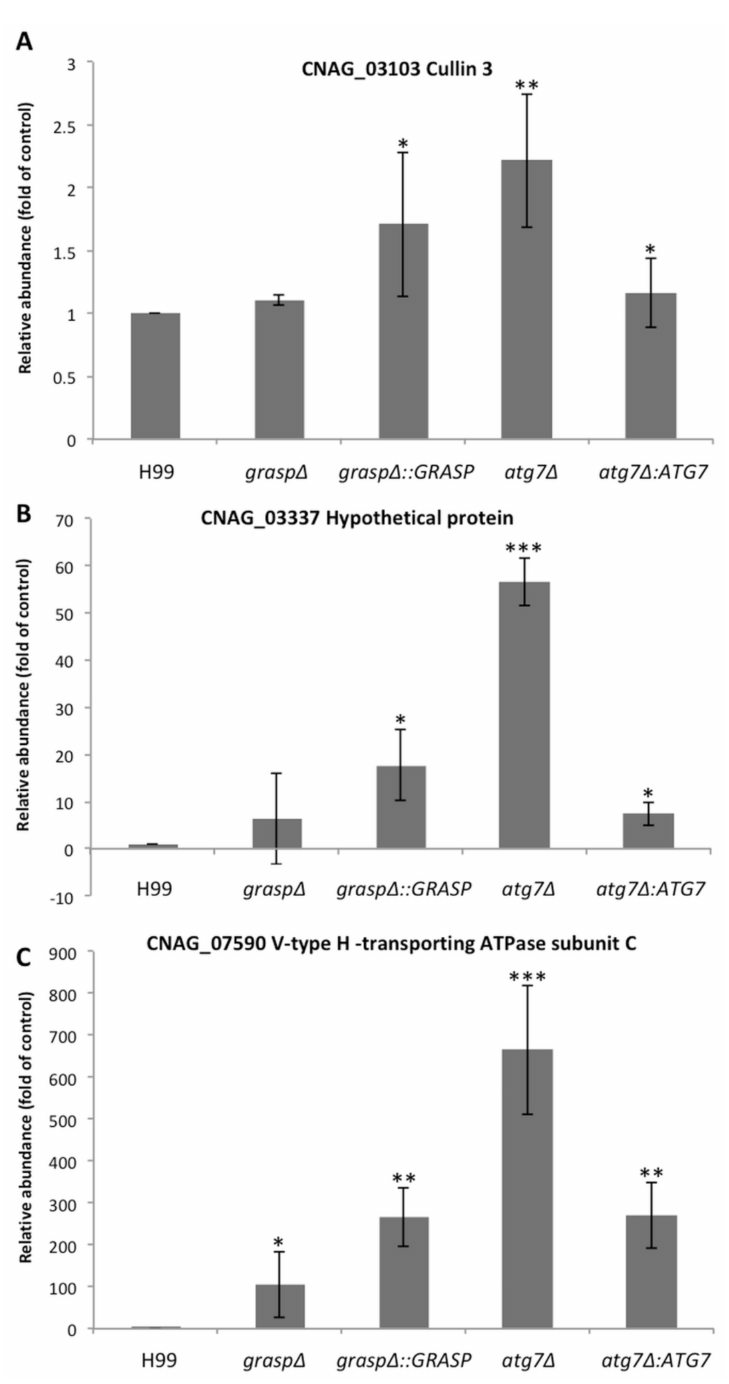
Figure 5. Analysis of the cellular transcription levels of three vesicular RNA sequences. Transcript levels for ( A ) Cullin 3; ( B ) hypothetical protein CNAG_03337 and ( C ) V-type H + -transporting ATPase subunit C were normalized to the levels of actin transcripts. The X-axis corresponds to each strain analyzed (WT, grasp ∆ , grasp ∆ :: GRASP , atg7 ∆ and atg7 ∆ :: ATG7 ). The y -axis corresponds to the relative expression level of the mRNAs in the cell. Each bar represents the mean and standard error of triplicate samples. * p < 0.05; ** p < 0.01; *** p <